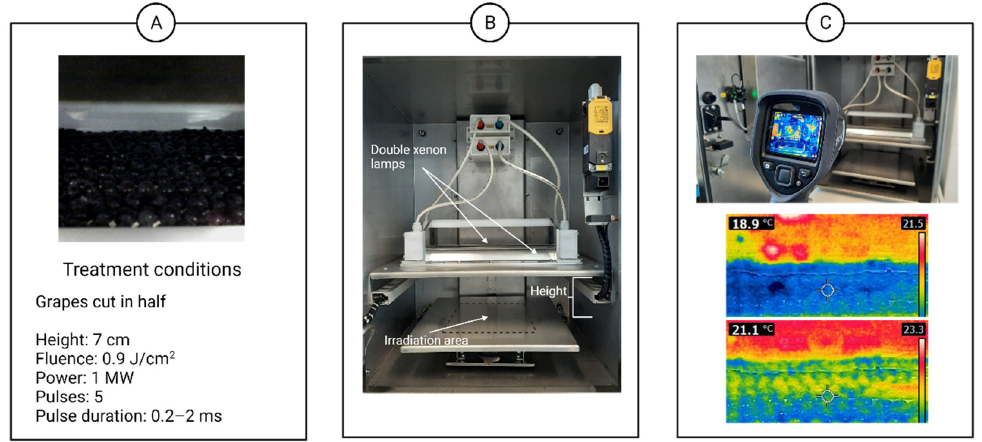
Figure 1. Sequence showing ( A ) interior of the PL treatment chamber; ( B ) grapes cut in half and placed under the lamps; ( C ) thermal camera used ( above ) and thermal effect ( below ).